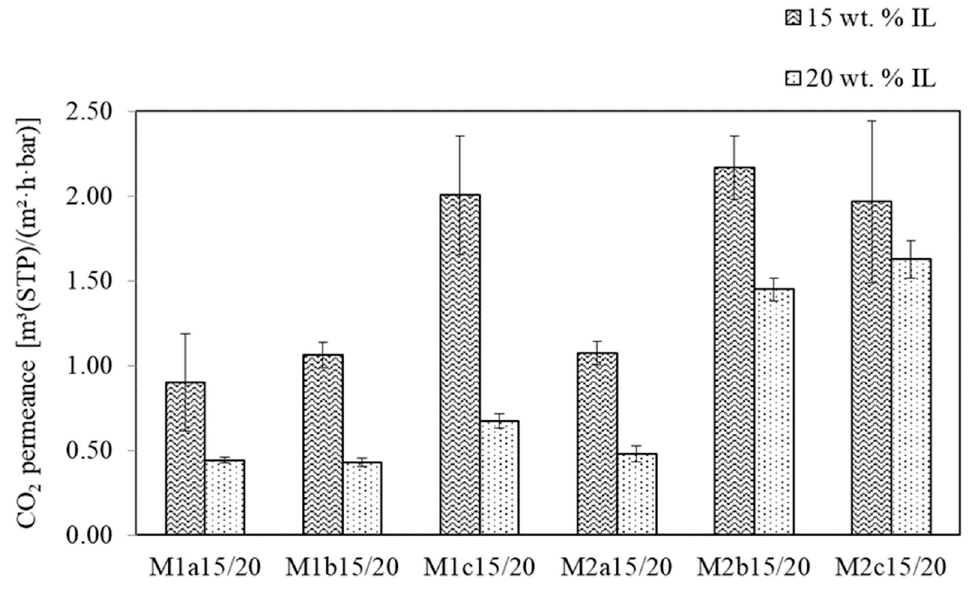
Figure 8. CO 2 single gas permeances of M1/2a15/20–M1/2c15/20 at ϑ = 28 °C and ∆ p = 2 bar.